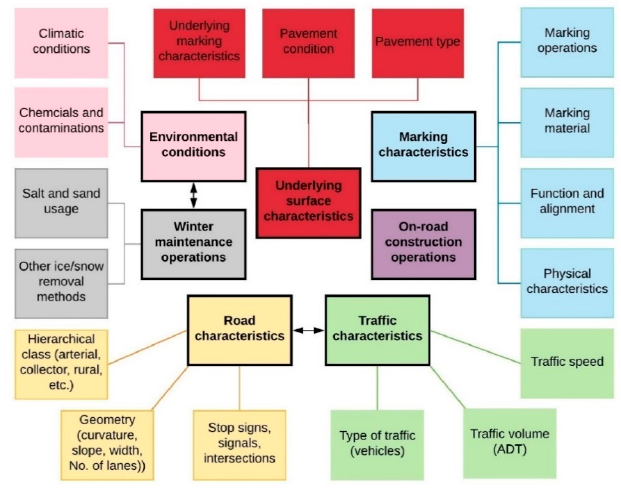
Figure 2. Major factors affecting pavement marking durability.